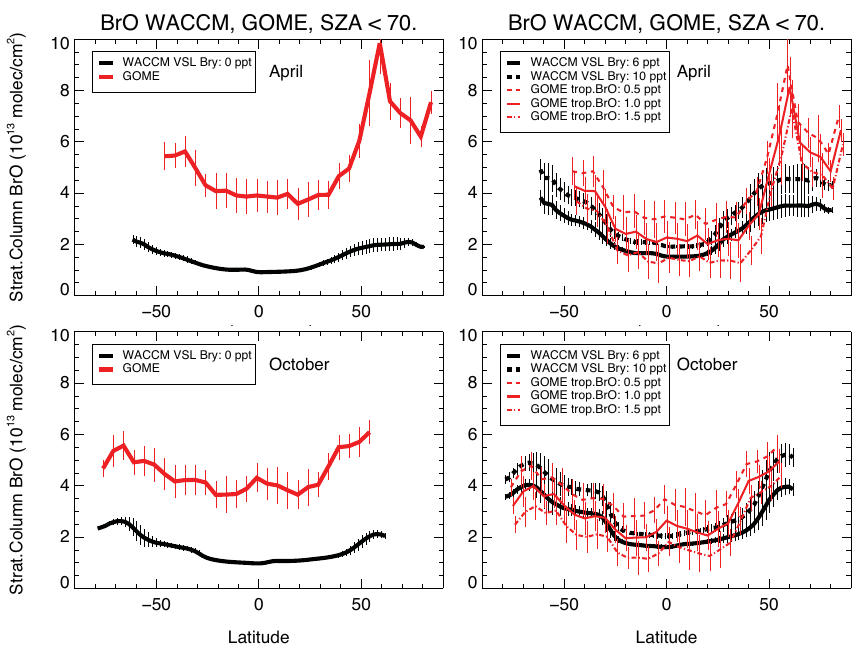
Fig. 1. Left panels: comparison of zonal average of total column BrO from GOME satellite observations in 1997 (Chance, 1998) (red lines) to WACCM stratospheric column BrO (black lines) for the year 2000. Right panels: inferred stratospheric column BrO from GOME total column adjusted for the presence of various amounts of tropospheric BrO (see text) (red lines, see legend) and zonal average of WACCM stratospheric BrO column, assuming different levels of Br VSL y (black lines; see legend). Top panels are for April and bottom panels for October. Error bars on all curves reflect the longitudinal variability (standard deviation about the zonal, monthly mean). WACCM BrO is for 10:30 a.m., the equator crossing time of